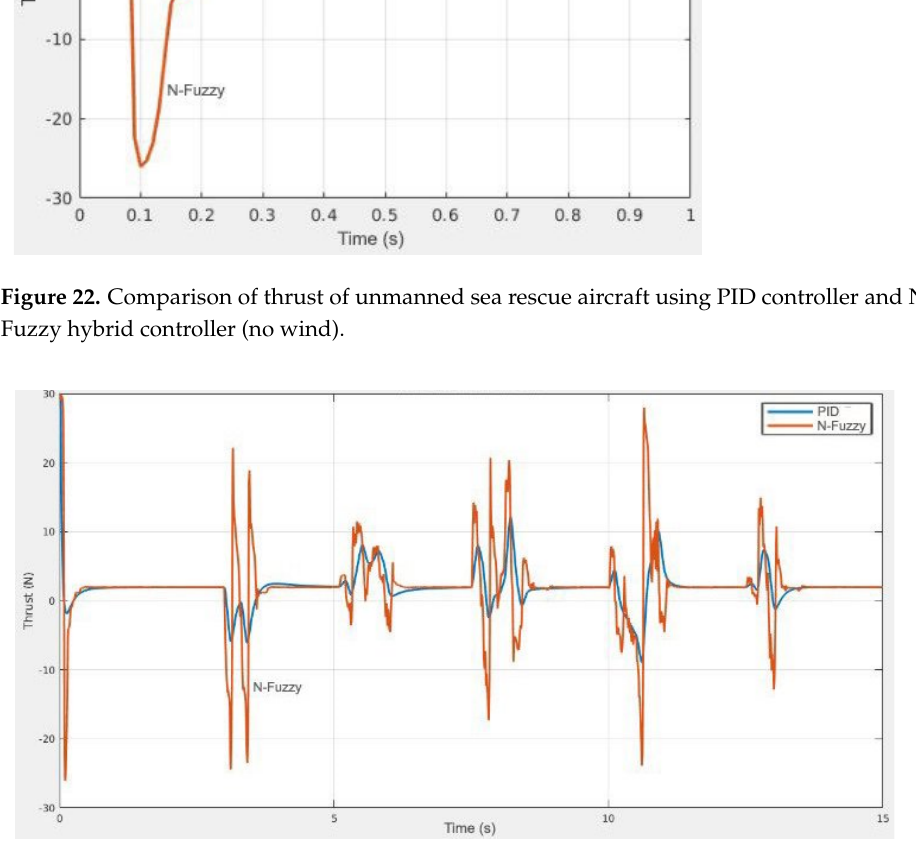
Figure 23. Comparison of thrust of unmanned sea rescue aircraft using PID controller and Neural- Fuzzy hybrid controller (wind action).